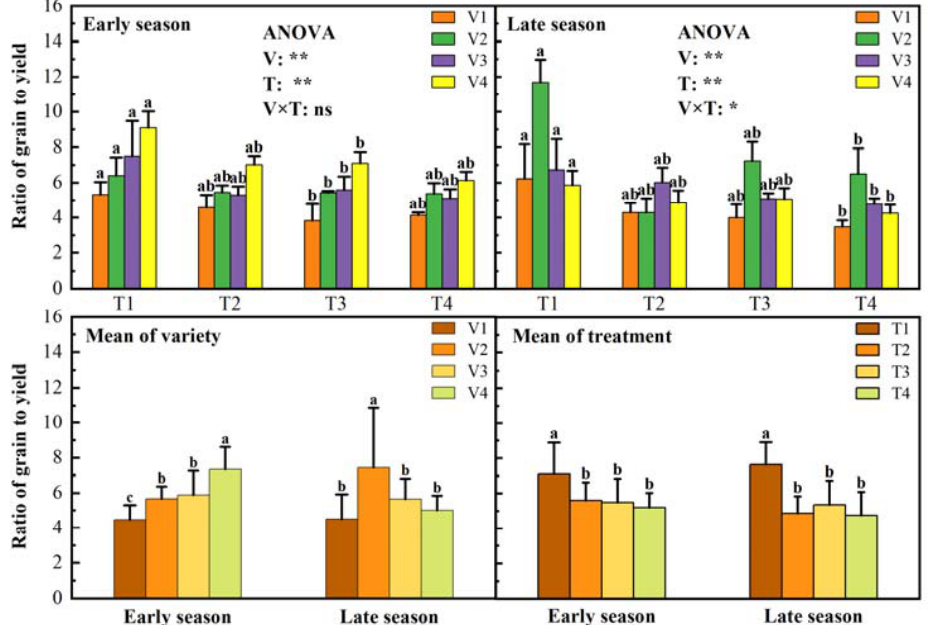
Figure 3. Effects of different treatments on grain to leaf ratio of rice. Note: T1, 1 seeding per hill + row spacing 12.93 cm; T2, 3 seedings per hill + row spacing 22.33 cm; T3, 6 seedings per hill + row spacing 31.67 cm; T4, 9 seedings per hill + row spacing 38.80 cm; different lowercase letters within subgraphs indicate significant differences between treatments ( p < 0.05); The longer the error bars, the greater the variability of the sample data in the group. ** indicates significance at 0.01, * indicates significance at 0.05, ns indicates no significance.